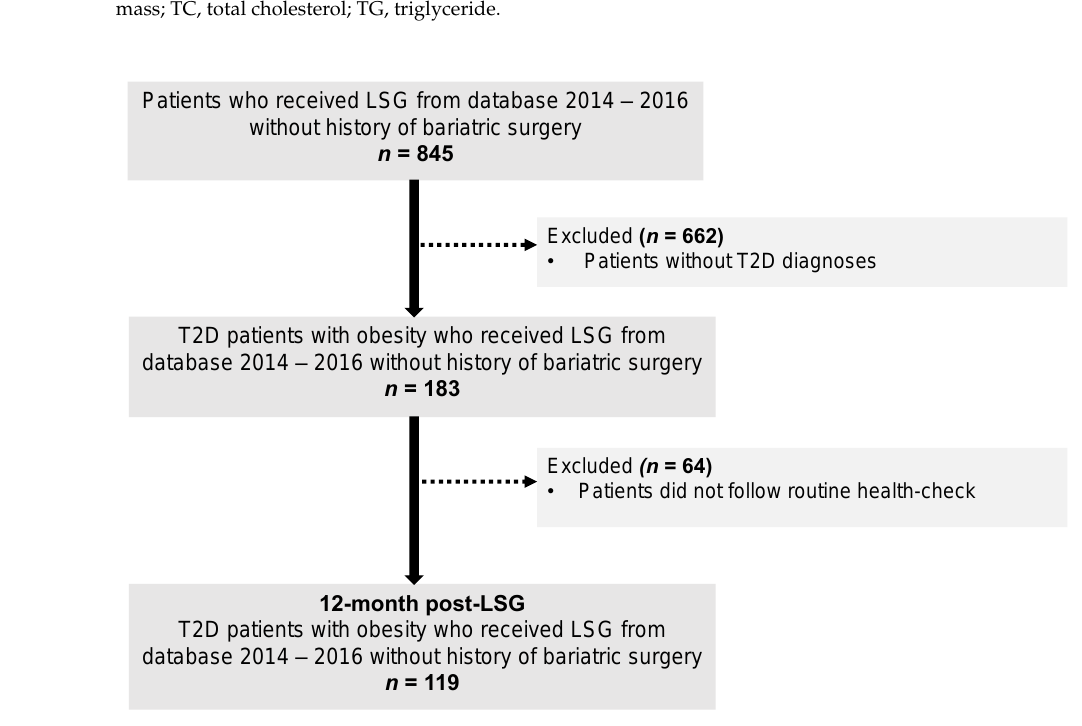
Figure 1. The flowchart of the study. Abbreviation: LSG, Laparoscopic sleeve gastrectomy; T2D, type 2 diabetes. Table 1. Baseline demographic and disease characteristics.